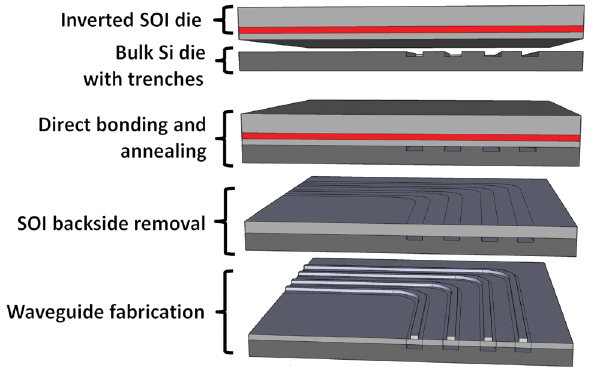
Figure 12 Fabrication steps of ASOP dies [200].